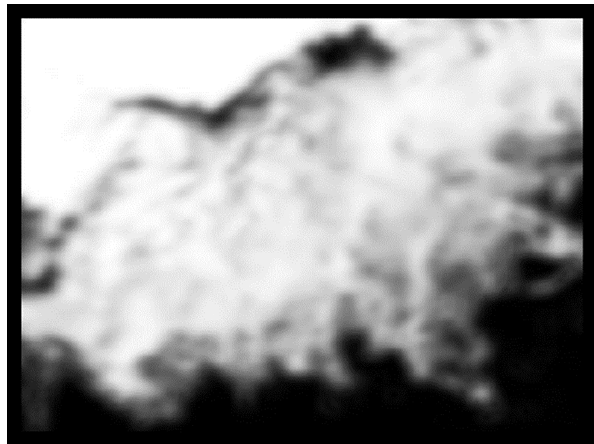
Figure 2. The simulated ice concentrations using the SSM/I sen- sor specifications and the OSISAF hybrid ice concentration algo- rithm and the data in Fig. 1 as input. Ice concentrations between 0% (black) and 100%